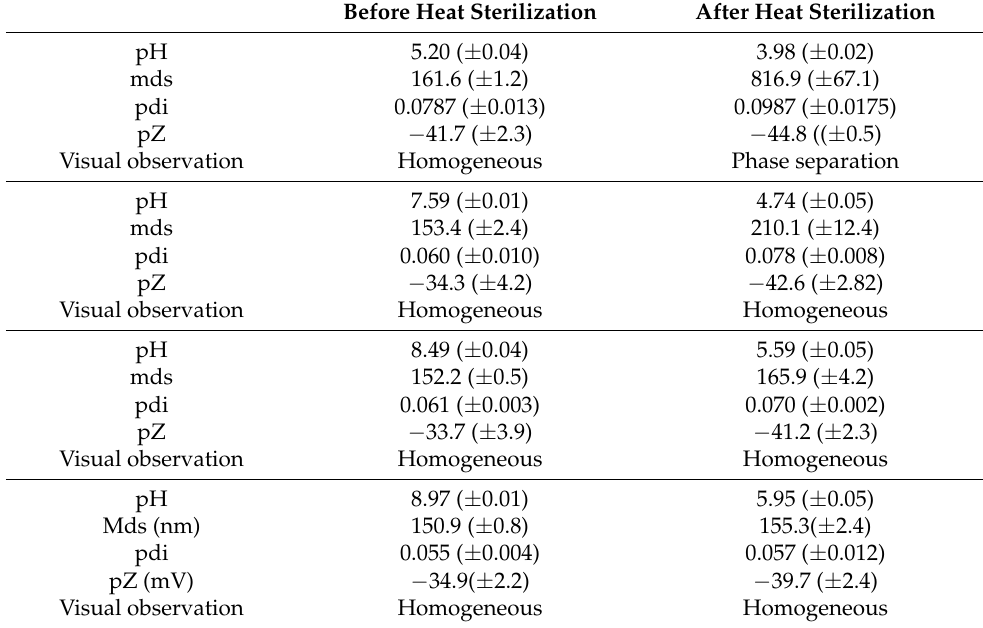
Table 4. Characteristics of NEs before and after autoclaving related to initial pH